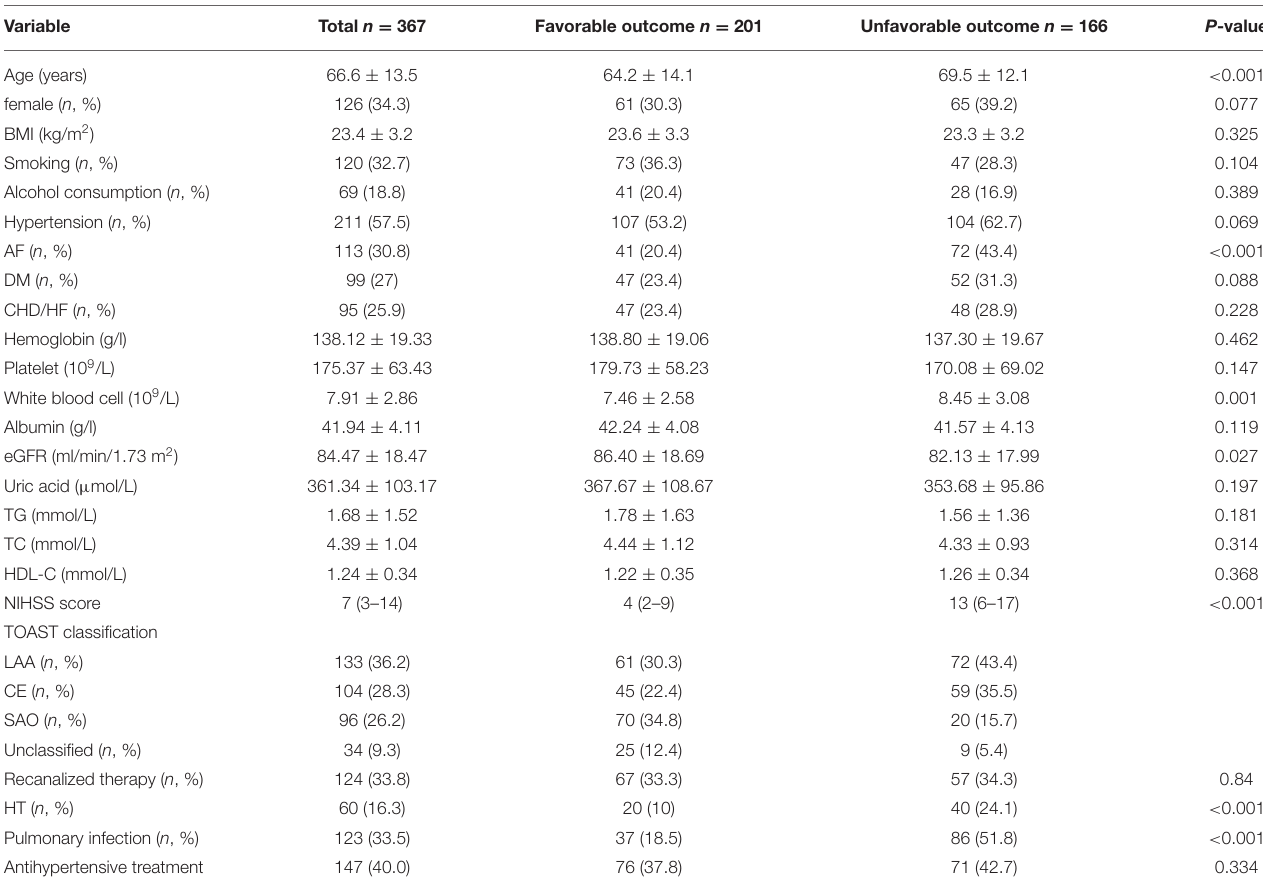
TABLE 1 | Comparison of baseline characteristics by functional status at 3